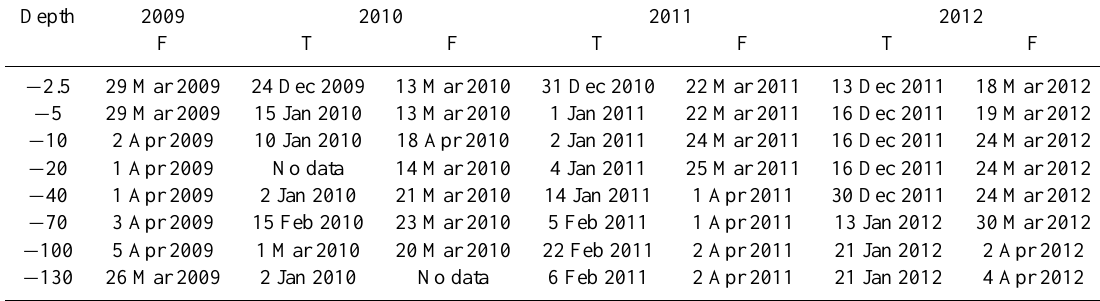
Table 2. Starting date (day/month/year) of the freezing (F) and thawing (T) seasons at different depths (in cm). Depth − 2.5